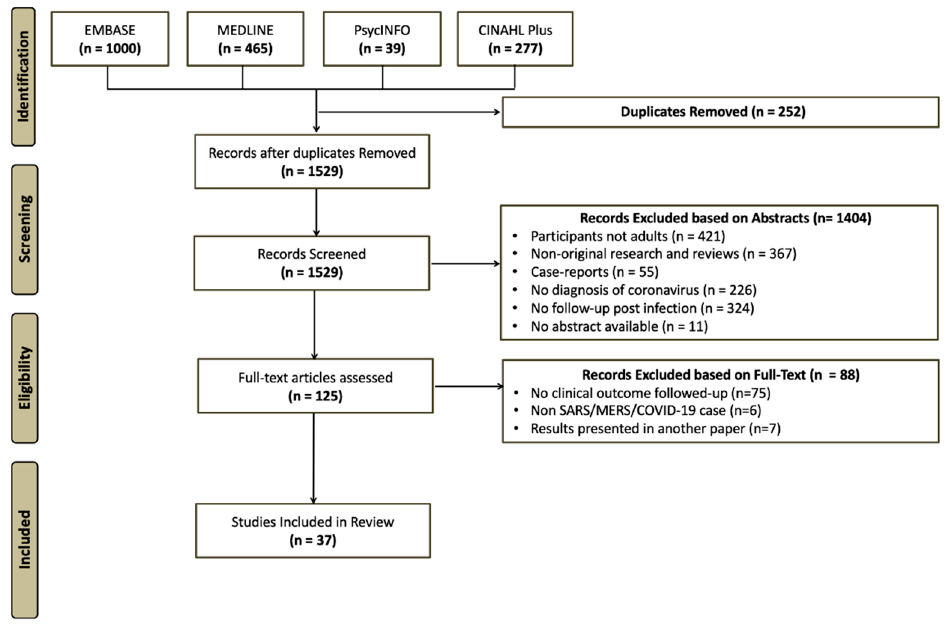
Figure 1. PRISMA flowchart for the literature search.